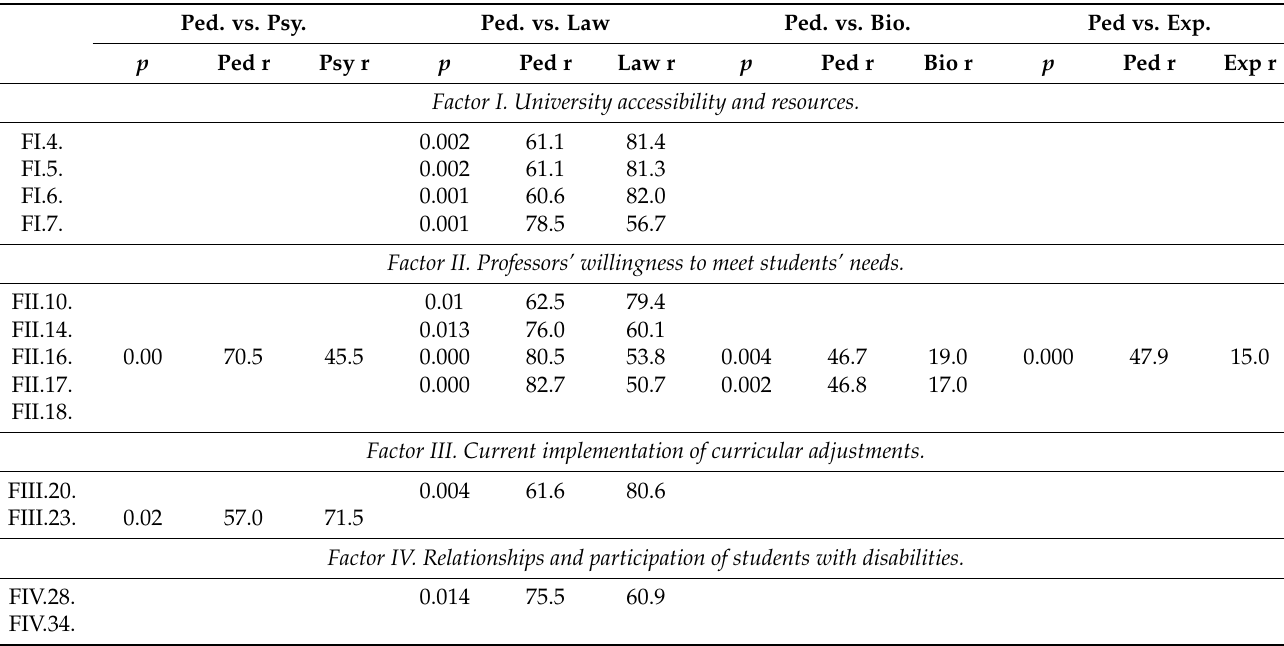
Table 13. Post hoc Kruskal–Wallis analysis analysis according to the teaching area (Pedagogy vs. others). Ped. vs. Psy. Ped. vs. Law Ped. vs. Bio. Ped vs.